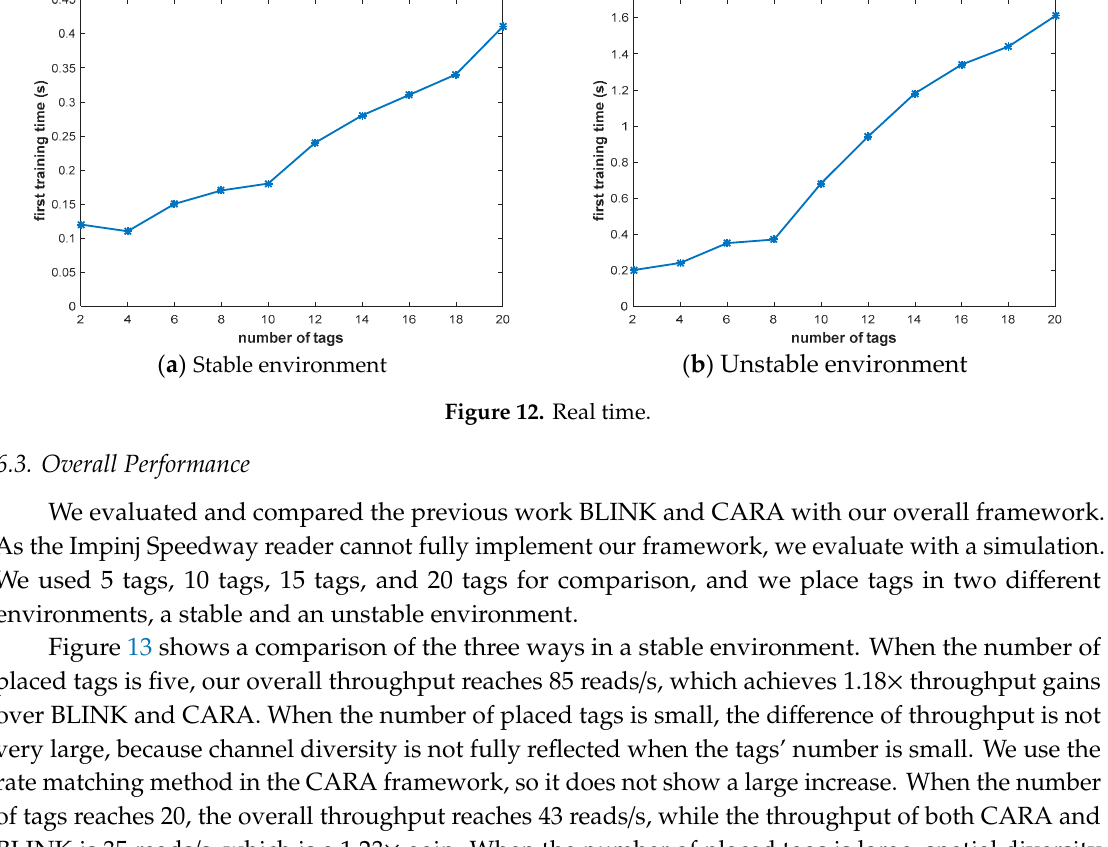
Figure 11. Predictive effect of packet loss rate.